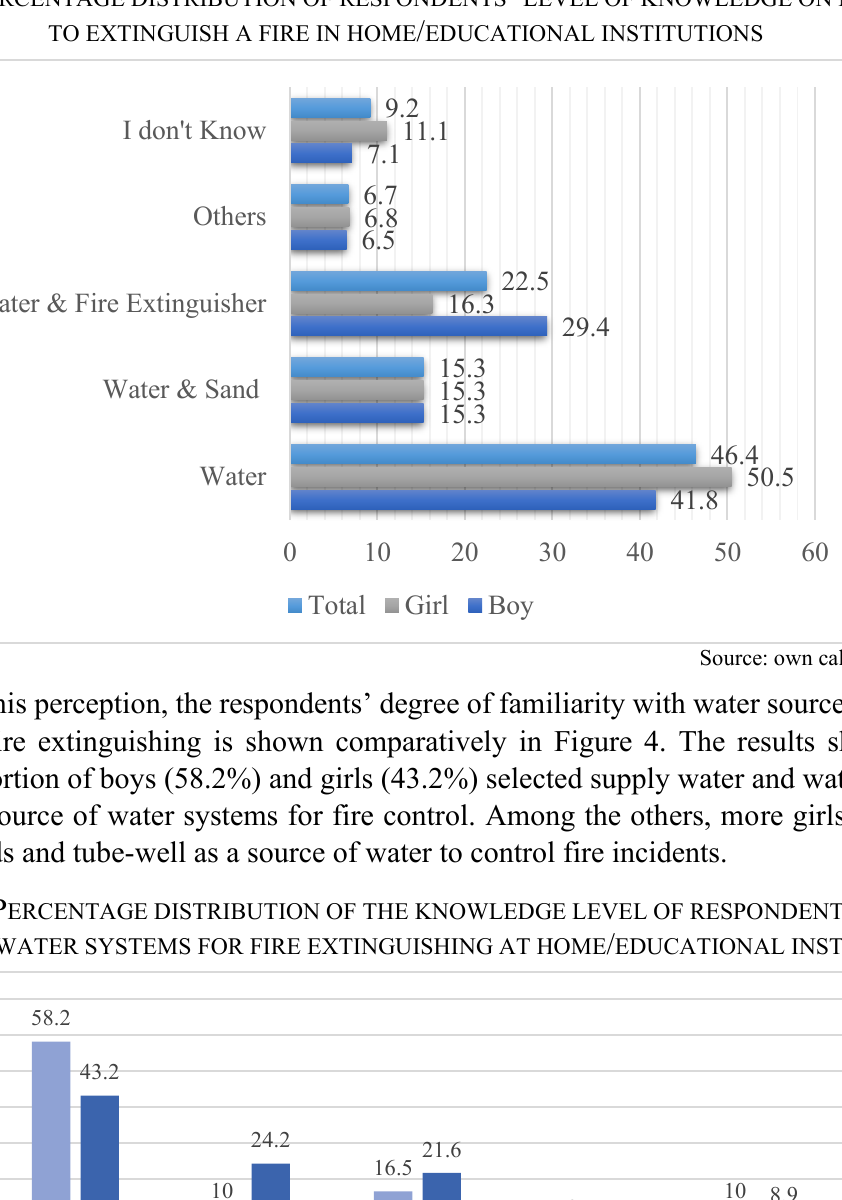
F IGURE 3. PERCENTAGE DISTRIBUTION OF RESPONDENTS ’ LEVEL OF KNOWLEDGE ON MEASURES TO EXTINGUISH A FIRE IN HOME / EDUCATIONAL INSTITUTIONS